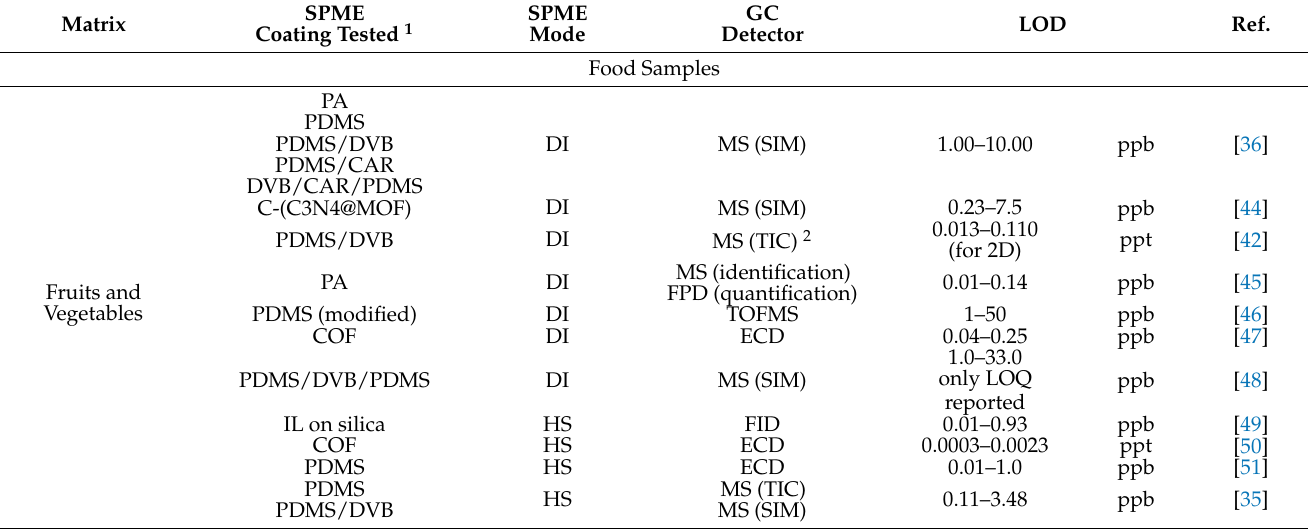
Table 1. Summary of the methods discussed in this review for the two main groups of samples, food and environmental.